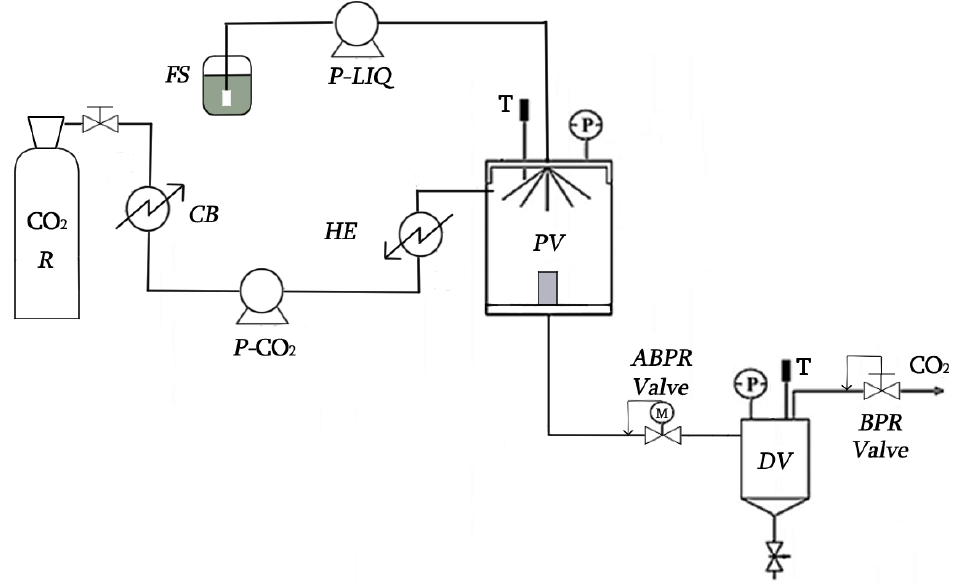
Figure 1. Scheme of the SAF equipment. Feed solution reservoir (FS); FS pump (P-LIQ); CO 2 reservoir (R); cooling bath (CB); CO 2 pump (P-SCF); heat exchanger (HE); precipitation vessel (PV); downstream vessel (DV); automatic back pressure regulator (ABPR); back pressure regulator (BPR); thermopar (T); Bourdon (P).